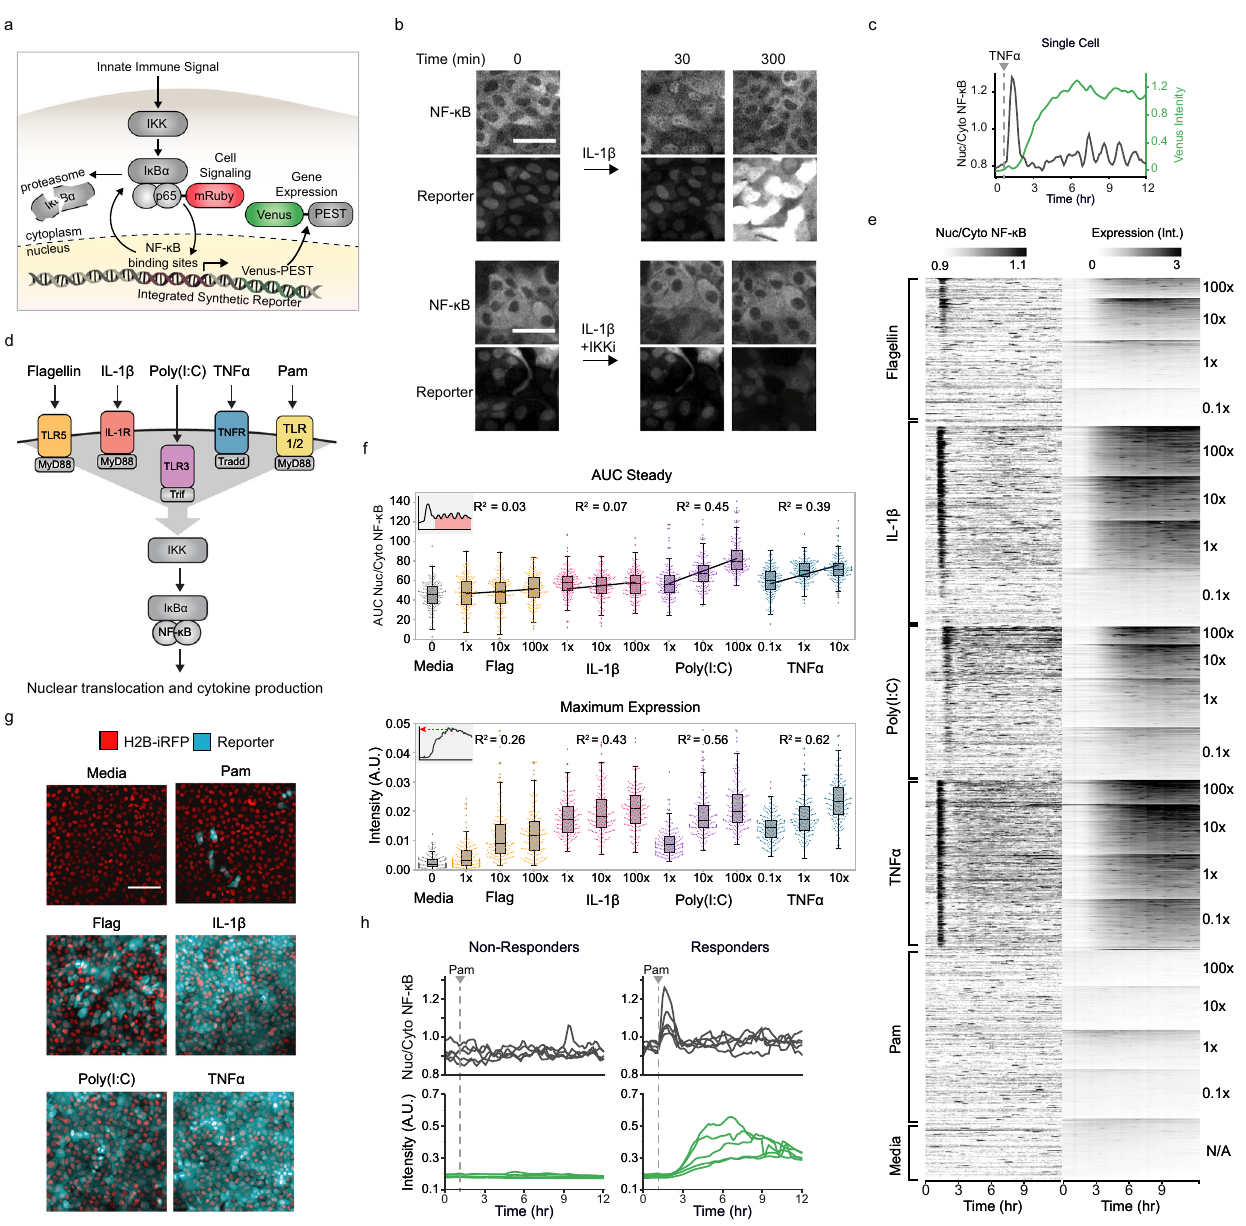
Fig. 1 MAMP sensing in epithelial monolayers shows digital and analog components. a Schematic detailing the NF- κ B-dependent gene expression reporter system. An innate immune signal activates IKK which phosphorylates I κ B α and sends it for degradation, freeing the fl uorescently tagged NF- κ B subunit (p65-mRuby) to enter the nucleus and transcribe the Venus-PEST reporter. b MCF10A NF- κ B reporter cells were incubated in the presence or absence of IL-1 β (10 ng/ml) and/or IKK inhibitor VII (10 µ M). Representative images from fi ve replicates taken at indicated times are shown. Scale bar, 50 μ m. c Representative single-cell trace. The median intensity of the nuclear/cytoplasmic NF- κ B is plotted in black, while the median nuclear + cytoplasmic intensity gene expression reporter is in green. d Schematic of innate immune receptors and inputs that signal to NF- κ B. TLR5, IL1R, and TLR1/2 all signal through MyD88. e Heatmap of all cells in the MAMP screen. MCF10A monoclonal reporter cell line was imaged for 50 min then treated with the indicated input and concentration. Concentrations at 100x were 1 µ g/ml (Flagellin), 200 µ g/ml (Poly(I:C)), 1 µ g/ml (Pam3CSK4), 1 µ g/ml (TNF α ), and 100 ng/ml (IL-1 β ). Heatmaps are ordered top to bottom from highest to lowest maximum Venus expression. f (Top) Swarmplots of the area under the curve after the fi rst NF- κ B translocation peak (AUC steady) in 200 cells randomly sampled from the indicated input and concentration. (Bottom) Swarmplots of the 95th percentile of the gene expression in 200 cells randomly sampled from the indicated input and concentration. R squared values of the linear regression model fi t to responses across the log of three concentrations. g Representative images of clonal MCF10A after 8 h of incubation with indicated stimulus (1 µ g/ml (Flagellin), 100 ng/ml (IL-1 β ), 20 µ g/ml (Poly(I:C)), 100 ng/ml (TNF α ), and 1 µ g/ml (Pam3CSK4)). H2B-iRFP nuclear marker is shown in red and Venus gene expression reporter is shown in cyan. Scale bar, 200 µ m. h MCF10A NF- κ B reporter cells stimulated with 1 µ g/ml Pam3CSK4. Traces of NF- κ B translocation (gray) and Venus expression (green) for fi ve non-responders and responders are shown.